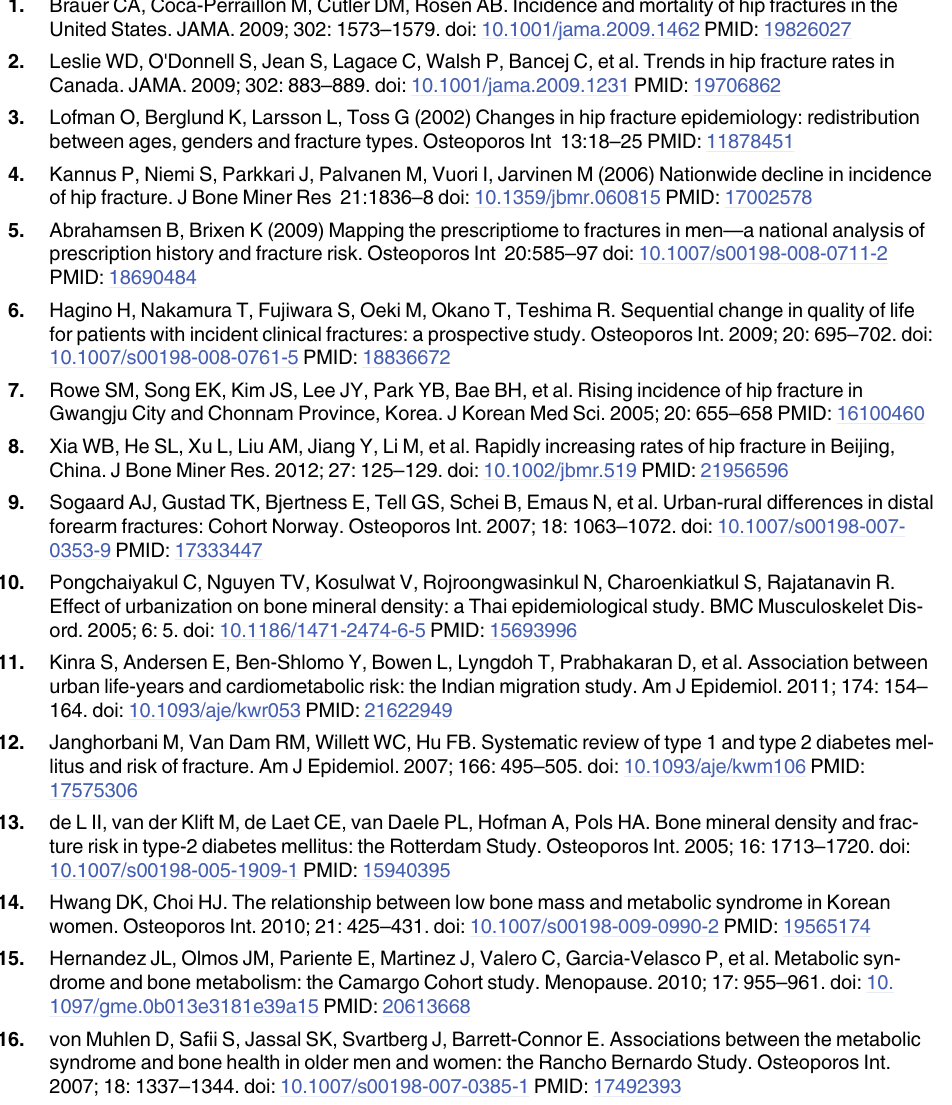
S1 Table. Bone outcomes and exposures in sibpair design (N = 185) with beta coefficient, SEM and